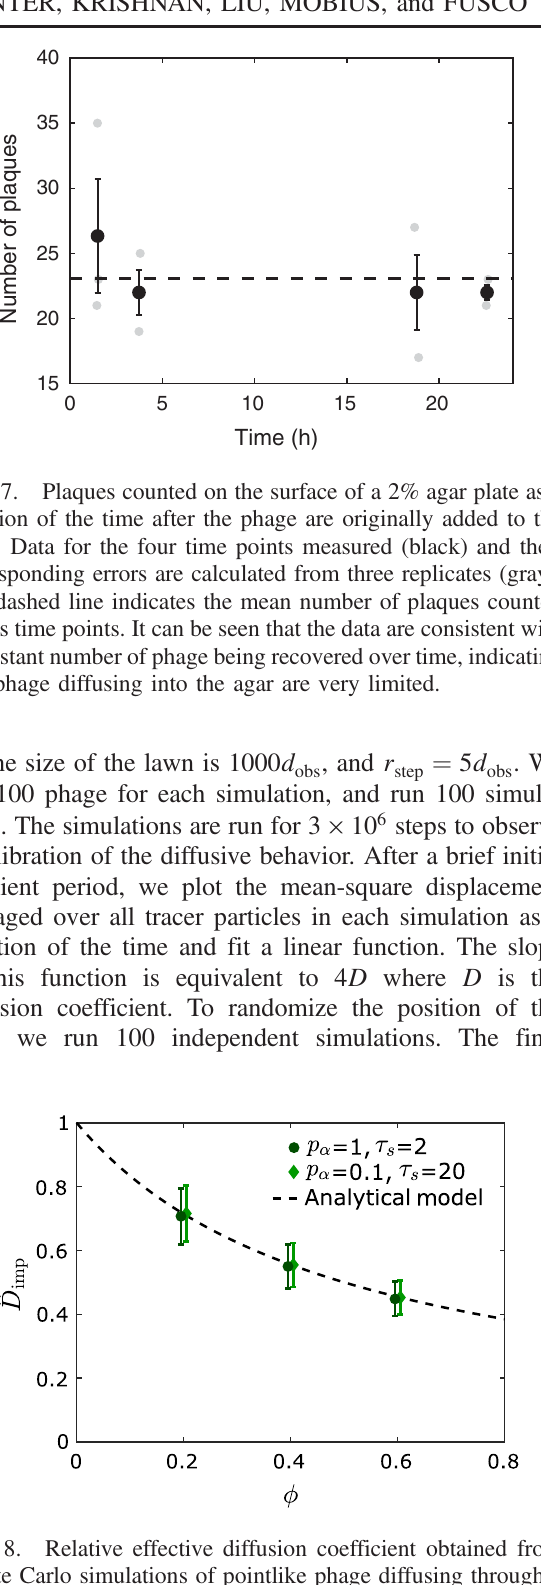
FIG. 9. The ratio of the explicit boost to diffusion implicit boost to diffusion ( 1 þ ψ ) as a function of f and K